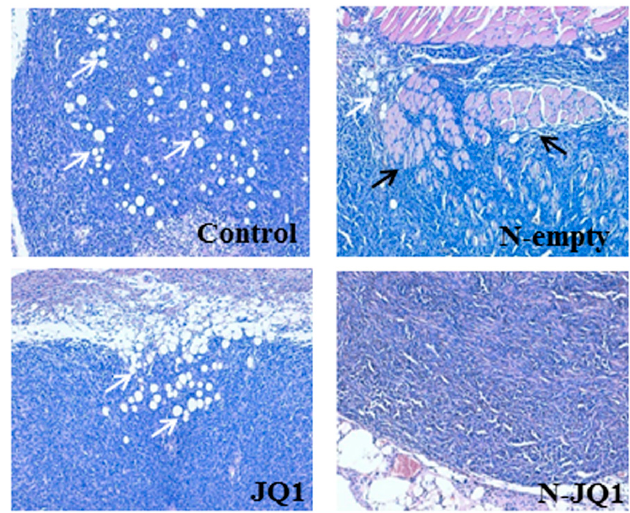
Figure 6. Tumor infiltration of tumor-surrounding tissues. Analyses of tumor tissues by hematoxylin and eosin staining of the four groups of animals after treatment with JQ1 (20 mg / kg) diluted in PBS + 5% PEG 400 + 5% TWEEN (JQ1), unloaded nanoparticles (N-empty) or nanoparticles containing JQ1 20 mg/Kg (N-JQ1). Black and white arrows indicate muscle and fat infiltrations, respectively. Magnification 100×. Cancers 2020 , 12 , x FOR PEER REVIEW